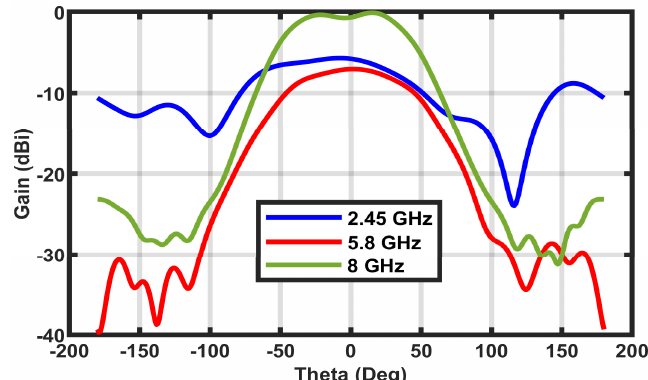
Figure 19. Variation in the gain of the antenna under phantom loading.